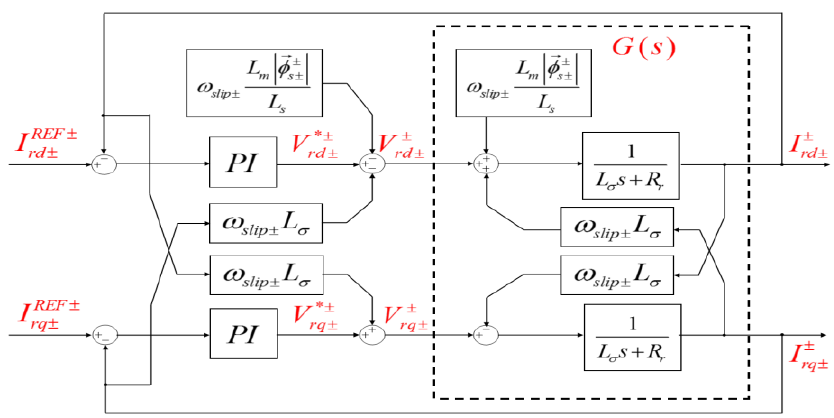
Fig. 1. DFIG normal operation rotor current controller Figure 4. DFIG normal operation rotor current Figure 4. DFIG normal operation rotor current controller.